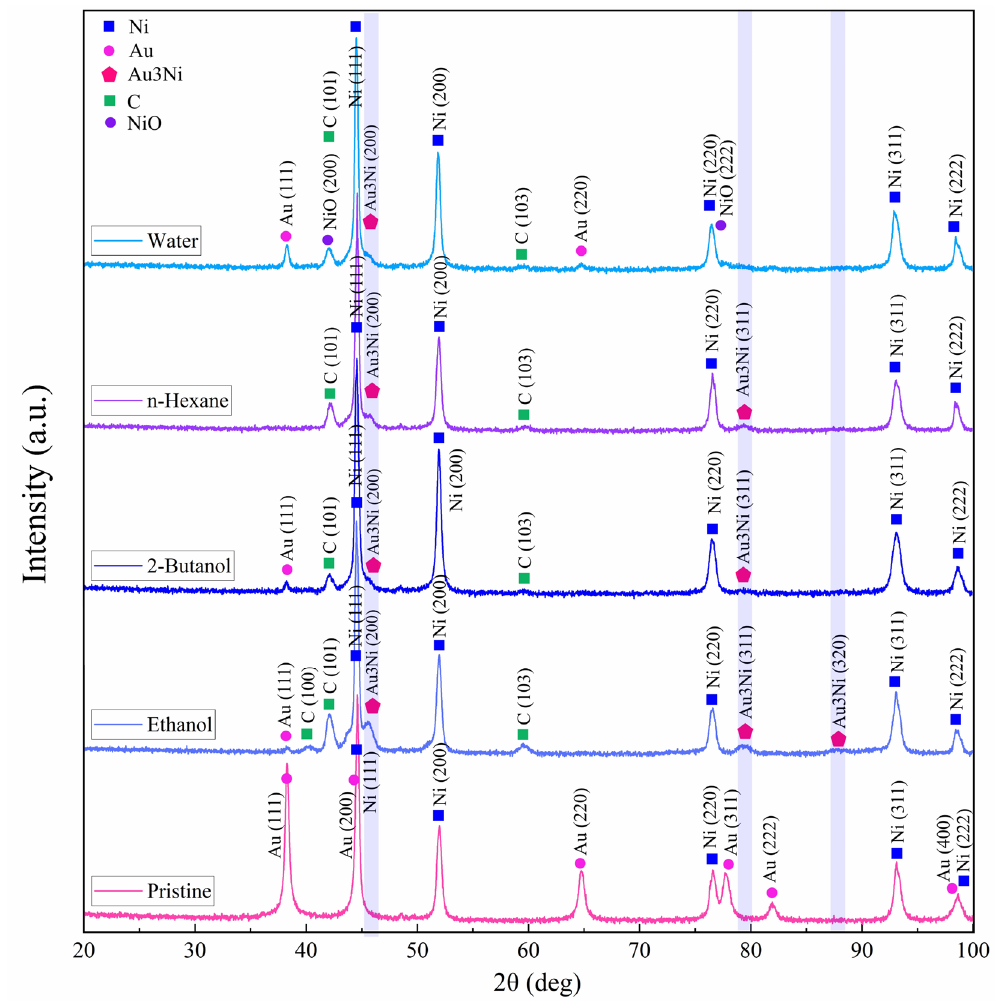
Figure 8. Micro ‐ GIXRD patterns of pristine and femtosecond ‐ processed Au/Ni areas, ( N = 1000, 1 kHz, E = 250 μ J). Figure 8. Micro-GIXRD patterns of pristine and femtosecond-processed Au/Ni areas, ( N = 1000, 1 kHz, E = 250 µ